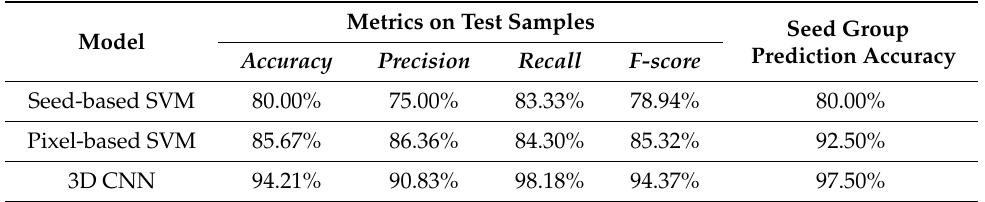
Table 2. The metrics of each